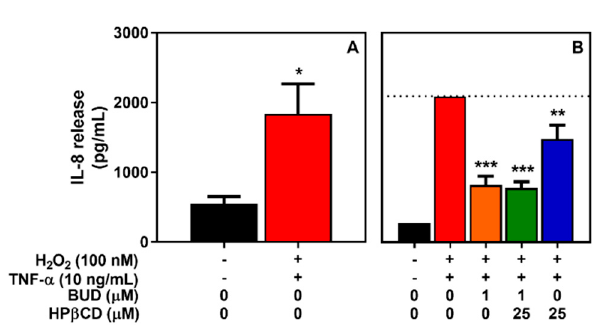
Figure 10. IL-8 release by A549 cells after treatment with H 2 O 2 + TNF- α for 2 h ( A ) and effect of the BUD:HP β CD complex versus BUD and HP β CD on H 2 O 2 + TNF- α -induced IL-8 release ( B ). IL-8 release was measured in the extracellular medium by sandwich ELISA. Results on panel B were normalized relative to untreated cells (0%) and H 2 O 2 + TNF- α -treated cells (100%). Each bar represents the mean ± SEM of 3 independent means of triplicated measures. (*), (**), and (***), indicate, respectively, p < 0.05, 0.01, and 0.001 versus non-treated cells ( A ) or H 2 O 2 +LPS-treated cells ( B ).